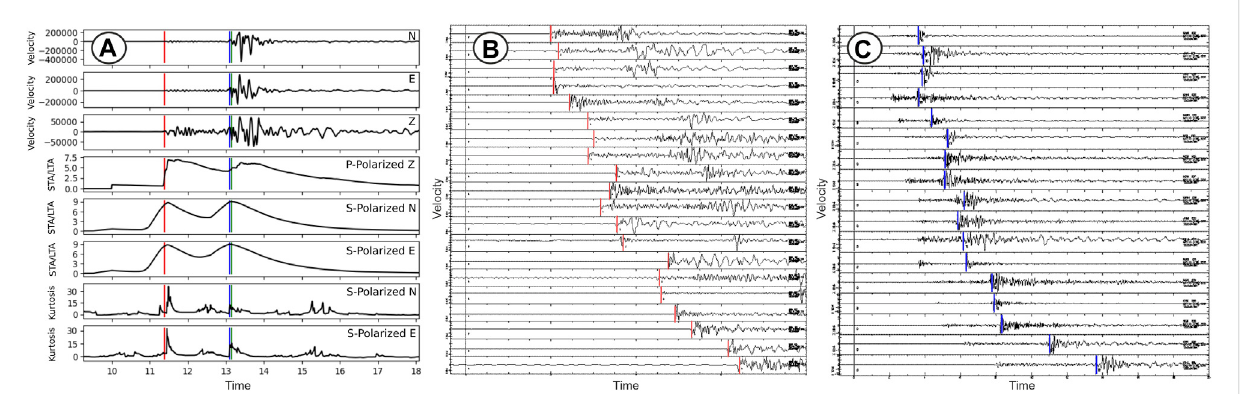
FIGURE 4 Example of P- and S- phase-picking for the M V 2.5 earthquake on 16/05/2011 at 13:25:04 (JST) in the Nagano region. (A) (From the top): 1) the 3-C velocity waveforms, 2) the STA/LTA characteristic functions for the P- (vertical) and S- waves (horizontal) polarized components, and 3) the kurtosis characteristic function calculated for the S-polarized horizontal components. The red and blue vertical lines show the P- and S-wave picks, respectively. (B) Seismic sections for vertical and (C) horizontal components of the stations for which a P-pick (red vertical line) and S-pick are available.